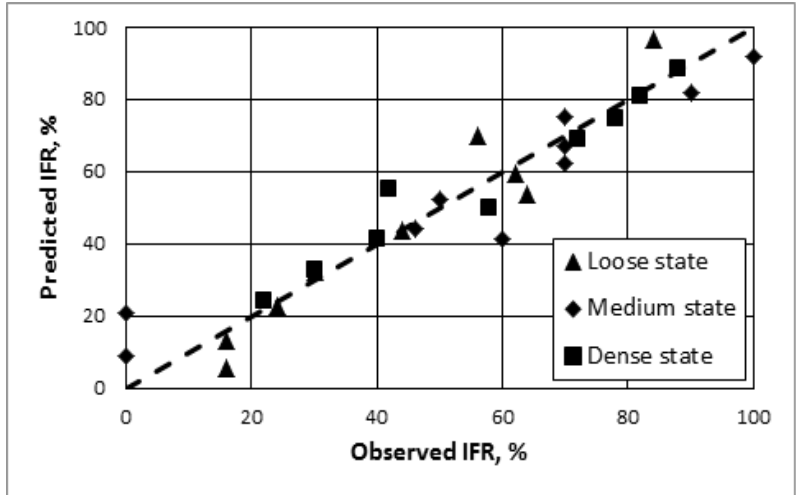
Fig. 4. Scatter plot of the observed and predicted IFR of Equation (3) for all data used in the regression analysis.